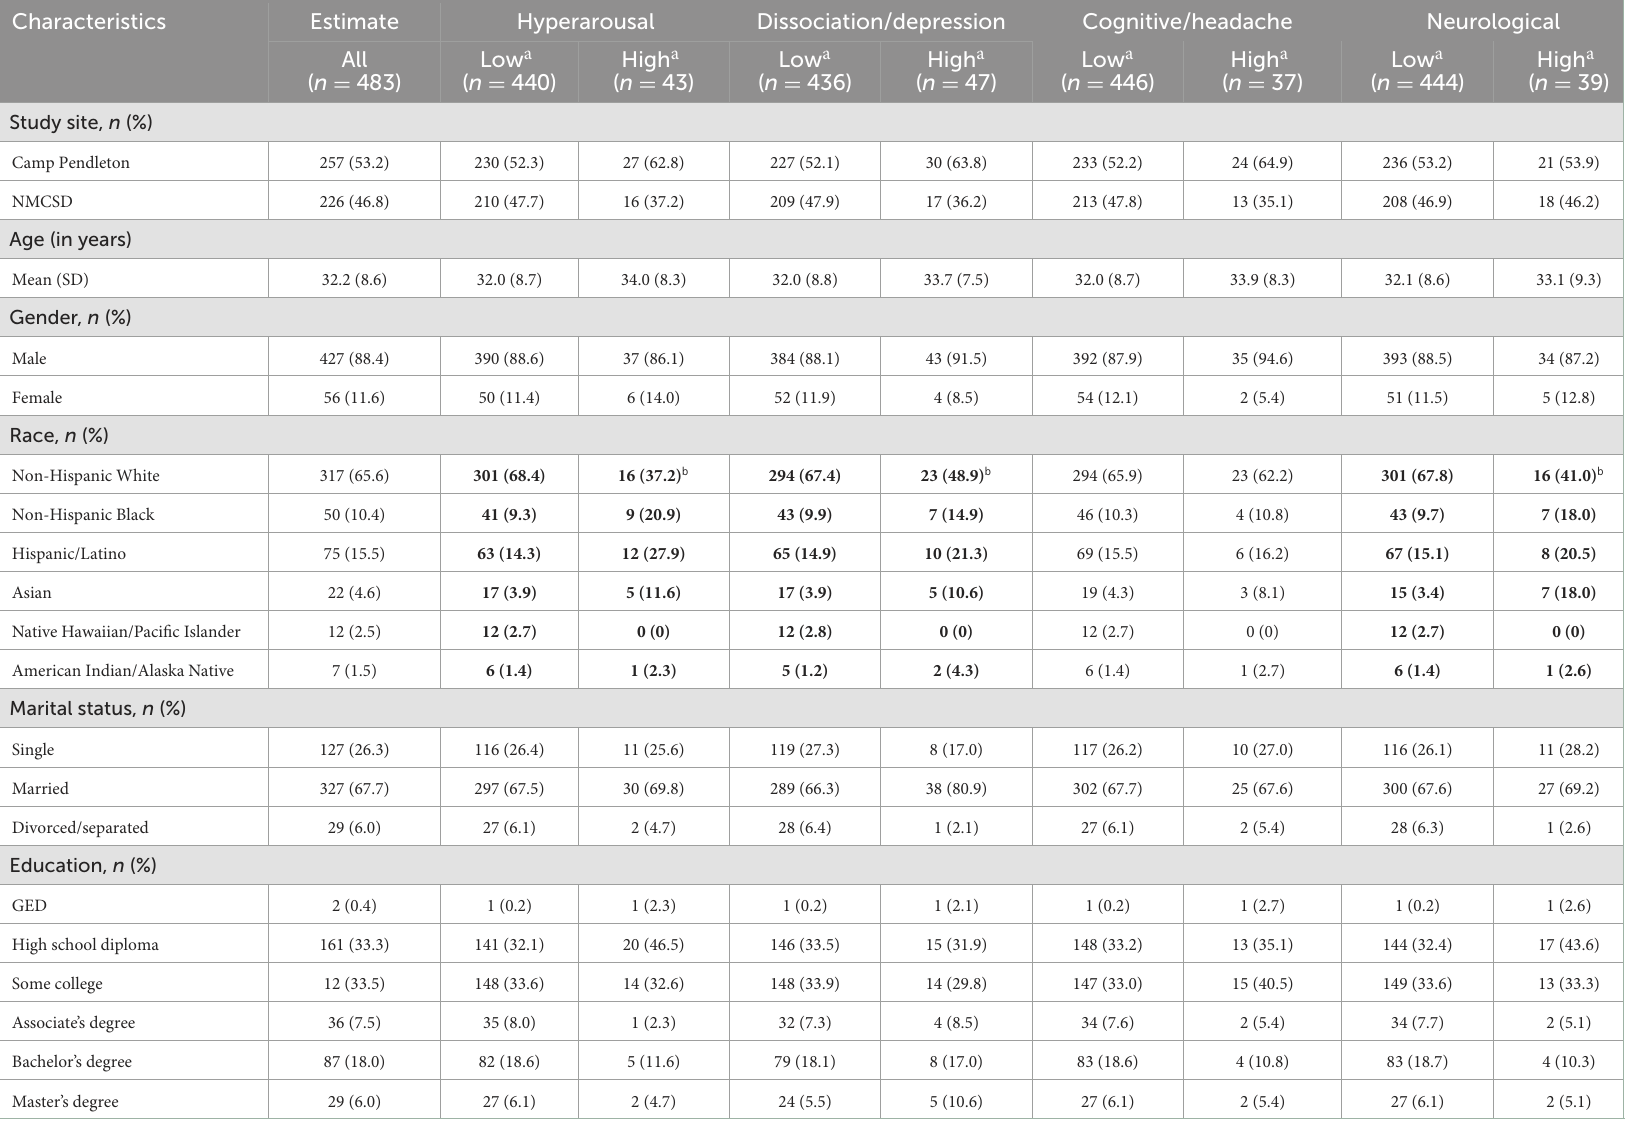
TABLE 1 Sample characteristics, overall and by initial symptom clusters ( n =